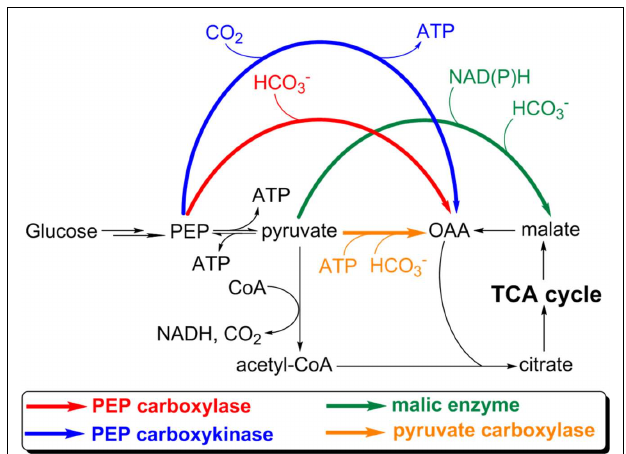
FIGURE 4 |Anaplerotic CO 2 assimilation reactions. The CO 2 -anaplerotic reactions catalyzed by pyruvate carboxylase, PEP carboxylase, PEP carboxykinase, and malic enzyme are shown. Participations or consumption of ATP and reducing equivalents are presented. Abbreviation: PEP, phosphoenolpyruvate; OAA, oxaloacetate.